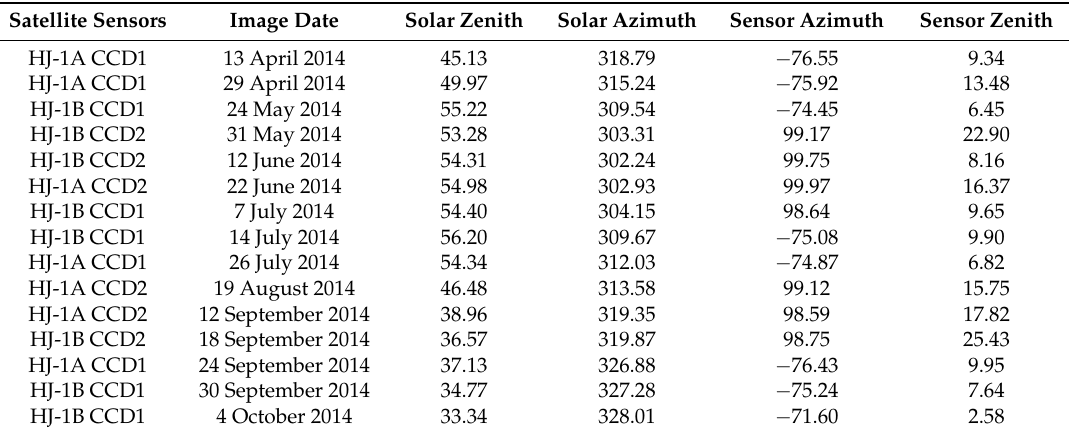
Table 6. Time-series HJ-CCD data of